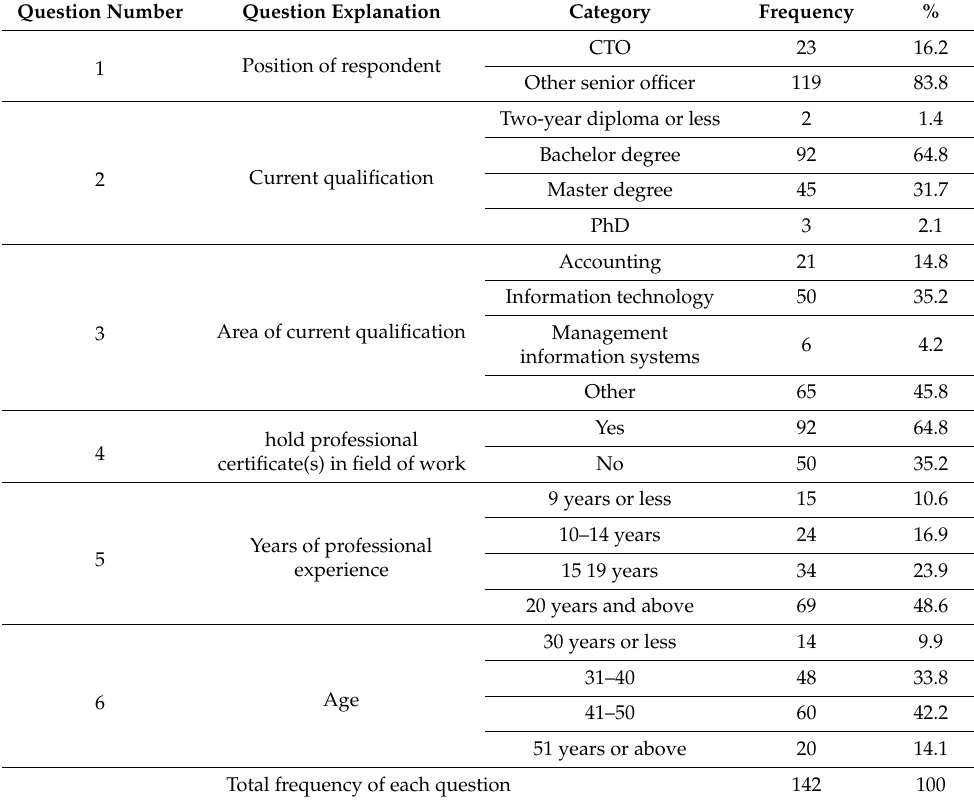
Table 2. The characteristics of the study